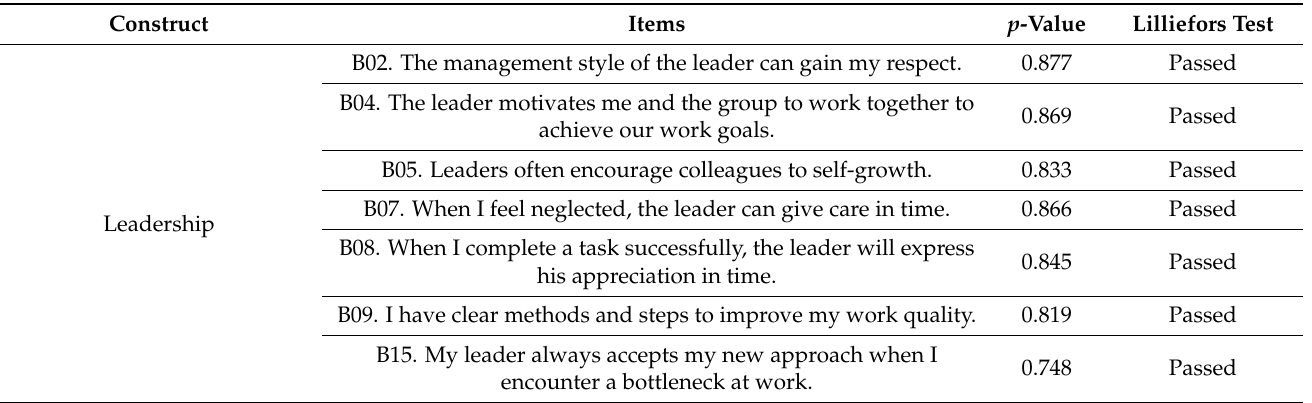
Table 1. Items that passed the Lilliefors